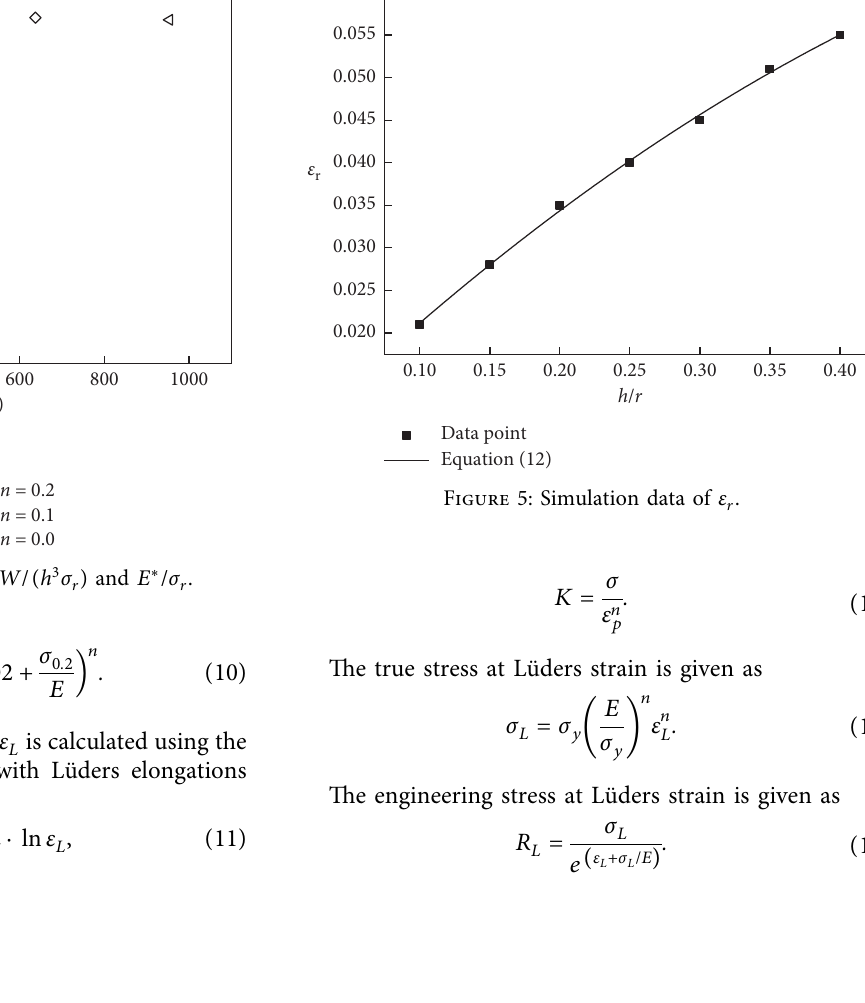
Figure 5: Simulation data of ε